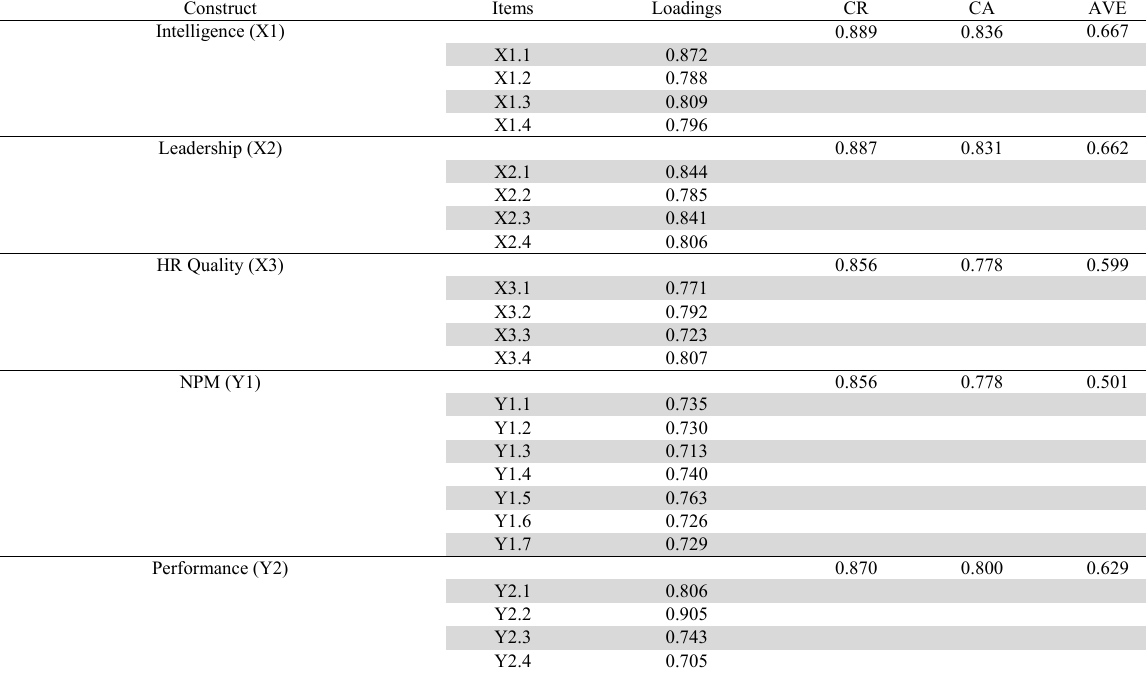
Convergent Validity and Reliability Measurement